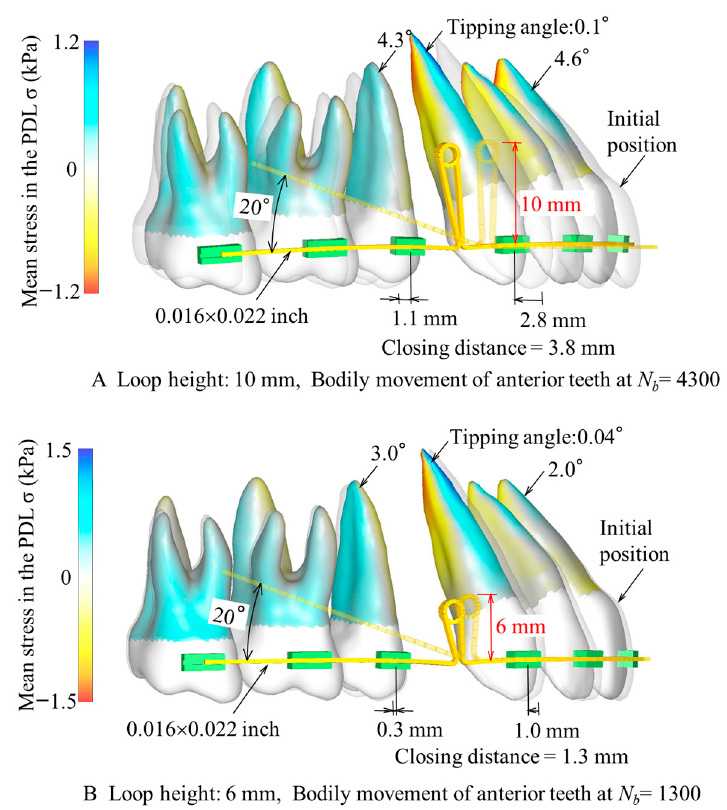
Figure 5. Effect of loop height. When loop height decreases, closing distance C and the number of repeated calculations N b decreases.